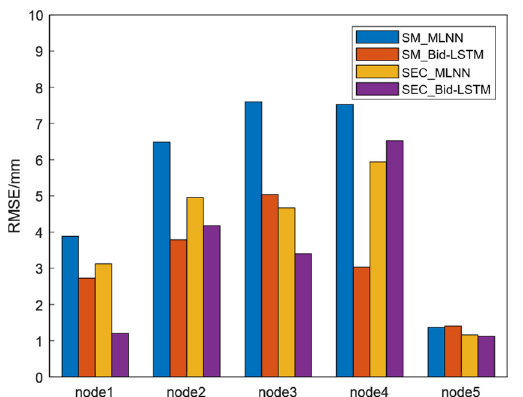
Figure 11. RMSE performance comparison results between LSTM and MLNN for the prediction of SM and SEC.